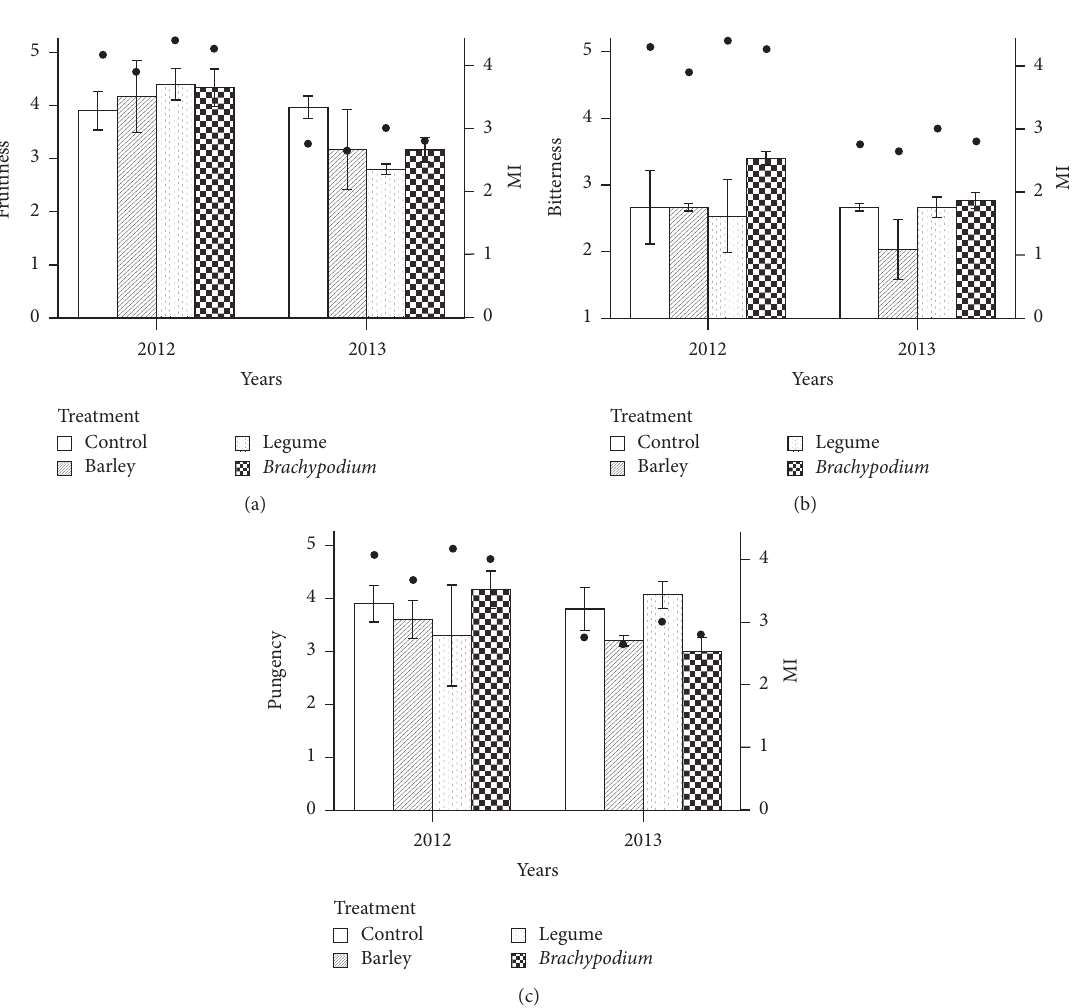
Figure 6: Fruitiness (a), bitterness (b), and pungency (c) mean and standard deviation and maturity index (MI) as dots of different treatments and years.